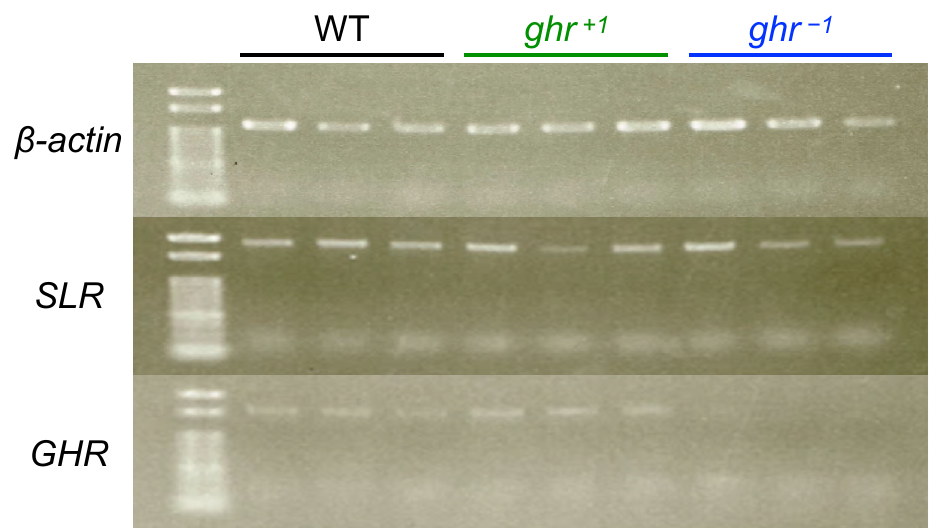
Figure 4. PT-PCR for three adults, each among WT, ghr +1 , and ghr − 1 fish. The upper lanes, middle lanes, and bottom lanes show the expression of beta-actin (22 cycles), SLR (28 cycles), and GHR (28 cycles), respectively. The transcripts of GHR were not detected in all three ghr − 1 individuals, whereas these bands were observed in all WT and ghr +1 individuals. Bands from RT-PCR products for beta-actin and SLR were detected in all individuals from all strains.